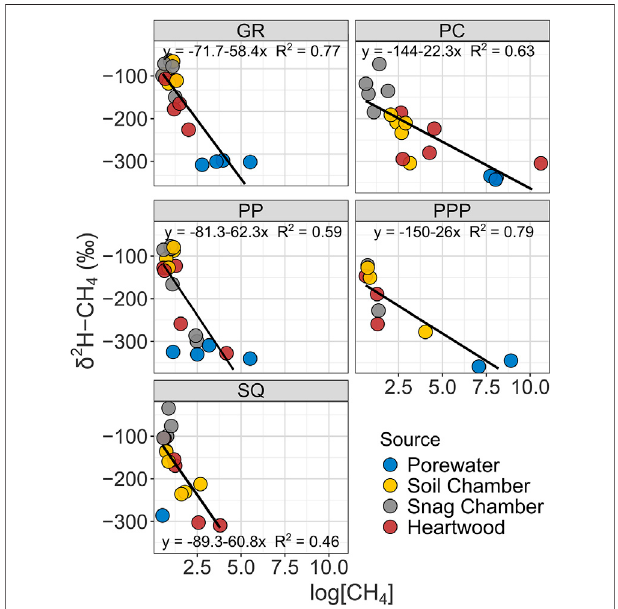
FIGURE 4 | Linear regressions showing relationship between δ 2 H-CH 4 stable isotopic values with CH 4 concentrations from various sources by study sites. Note all CH 4 concentrations were log transformed.